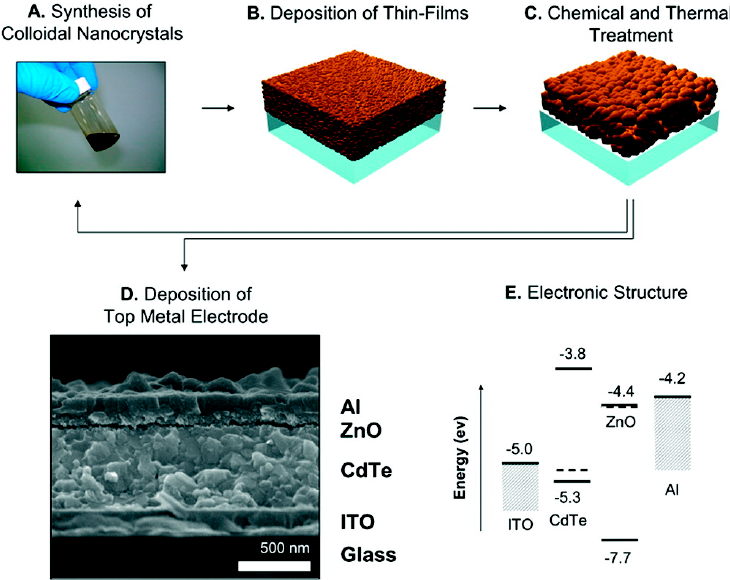
Figure 4. A general schematic of the layer ‐ by ‐ layer process for developing sintered inorganic thin ‐ film solar cells from colloidal nanocrystals. Reproduced with permission from [8]. Copyright 2011, American Chemical Society. ( A ) Synthesis of colloidal Nanocrystals. ( B ) Deposition of thin ‐ films. ( C ) Chemical and thermal treatment. ( D ) Deposition of top metal electrode. ( E ) Electronic structure.